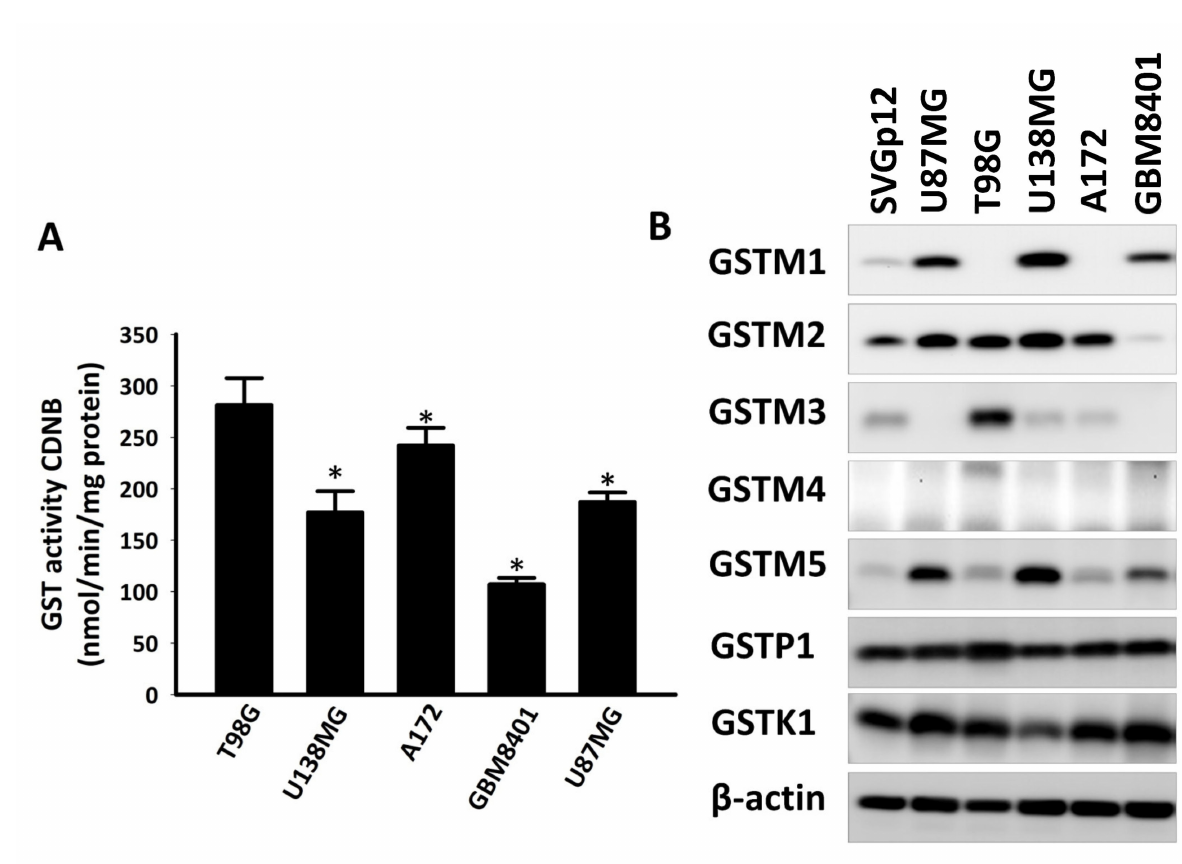
Figure 2. Glutathione S-transferase (GST) activity and GST subfamily member protein expression in glioblastoma cell lines. ( A ) The reaction mixture contained 100 µ g of cytosolic protein of each glioblastoma multiforme (GBM) cell line. Values are expressed as mean ± SD ( n = 3). * p < 0.05 relative to T98G cells. ( B ) Western blot analysis of GSTM1, GSTM2, GSTM3, GSTM4, GSTM5, GSTP1, and GSTK1 of human fetal glial cell line SVGp12 and human glioblastoma cell lines U87MG, T98G, U138MG, A172, and GBM8401. β -Actin was used as the loading